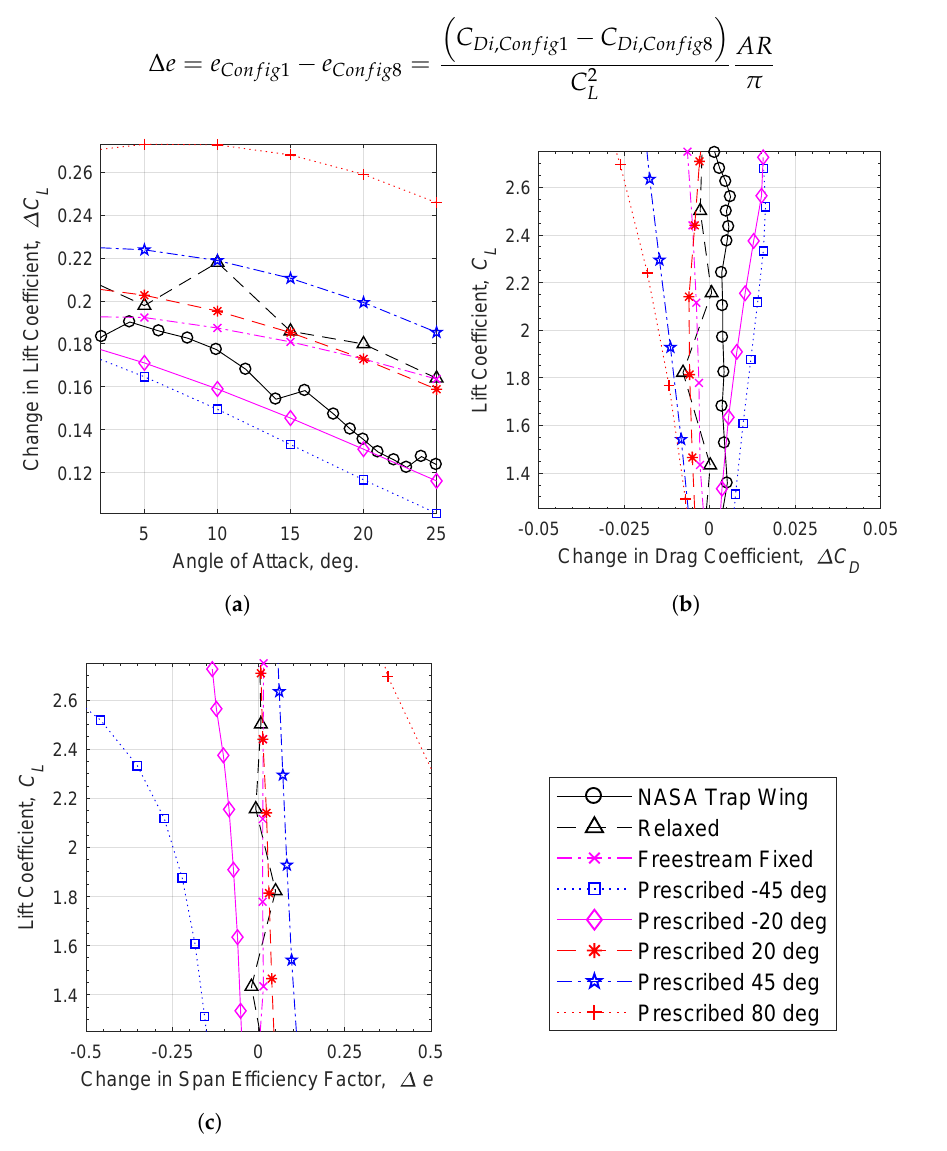
Figure 17. Predicted and experimentally-observed performance changes due to a flap deflection angle increase, from 20 deg to 25 deg. ( a ) Lift predictions, ∆ C L = C L , Config 1 − C L , Config 8 ; ( b ) drag predictions, ∆ C = C − C D D , Config 1 D , Config 8 ; ( c ) span efficiency predictions,